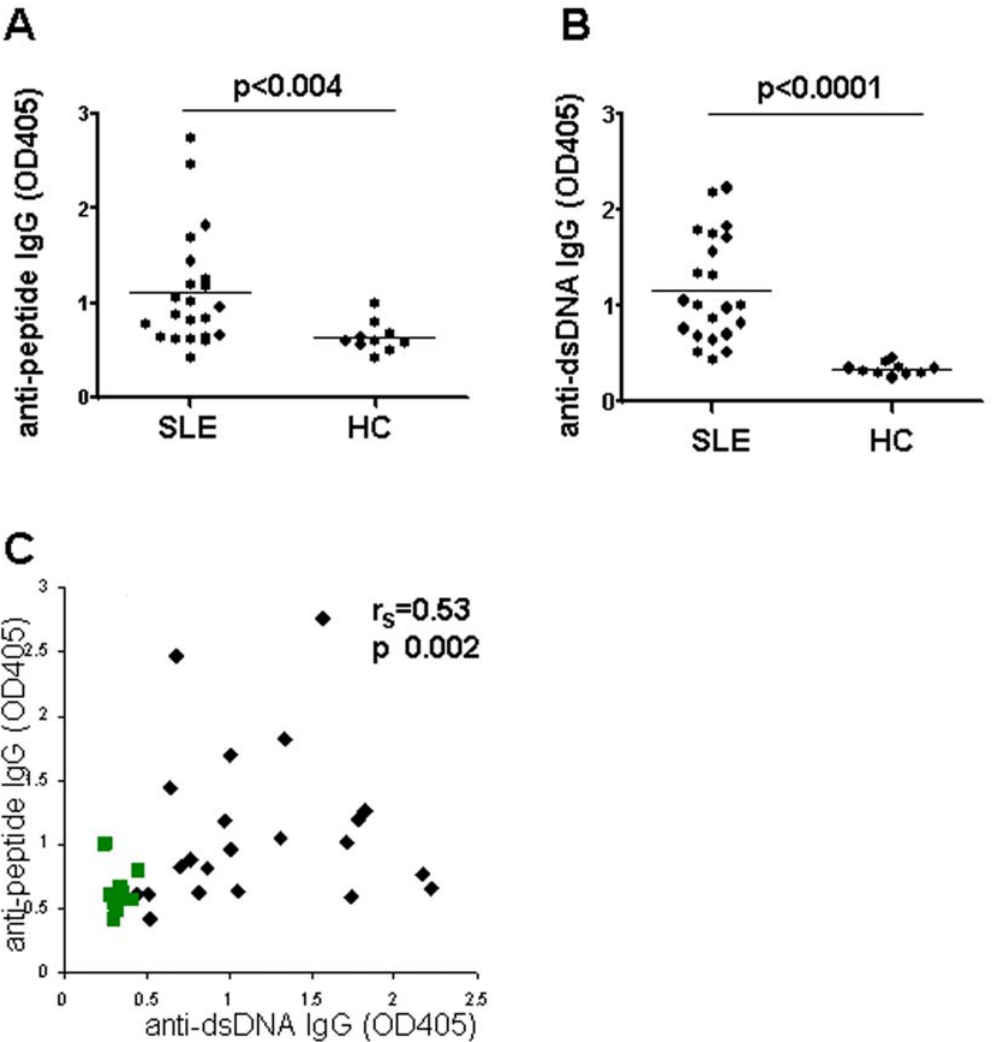
Figure 1. Antibody titters. A significant difference exists between the IgG anti-peptide ( A ) and anti-dsDNA ( B ) antibody levels in plasma samples of patients with SLE and healthy controls (Mann Whitney U-test, mean values are depicted). C. A significant correlation exists between anti-peptide IgG and anti-dsDNA IgG levels in all individuals analyzed. Healthy controls are shown in green, lupus patients in black (Spearman’s rank correlation test).